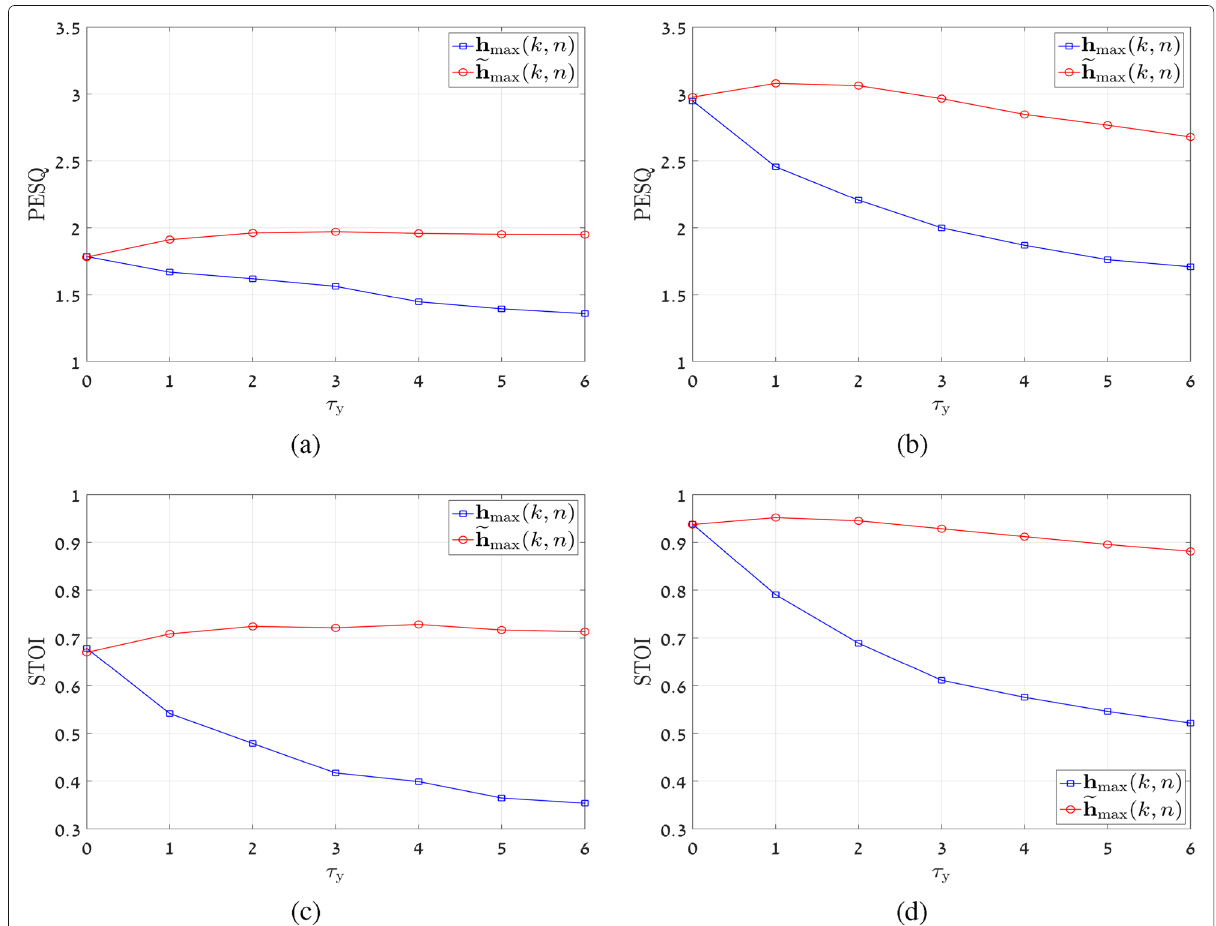
Fig. 2 PESQ and STOI scores of TIMIT speech signals as a function of the temporal smoothing preprocessing parameter τ y for N = 3 in the presence of white Gaussian noise: a PESQ scores with iSNR = − 5 dB, b PESQ scores with iSNR = 15 dB, c STOI scores with iSNR = − 5 dB, and d STOI scores with iSNR = 15 dB. The PESQ scores of the input noisy observation signal are 1.47 and 2.78 with iSNR = − 5 dB and iSNR = 15 dB, respectively; their corresponding STOI scores are 0.61 and